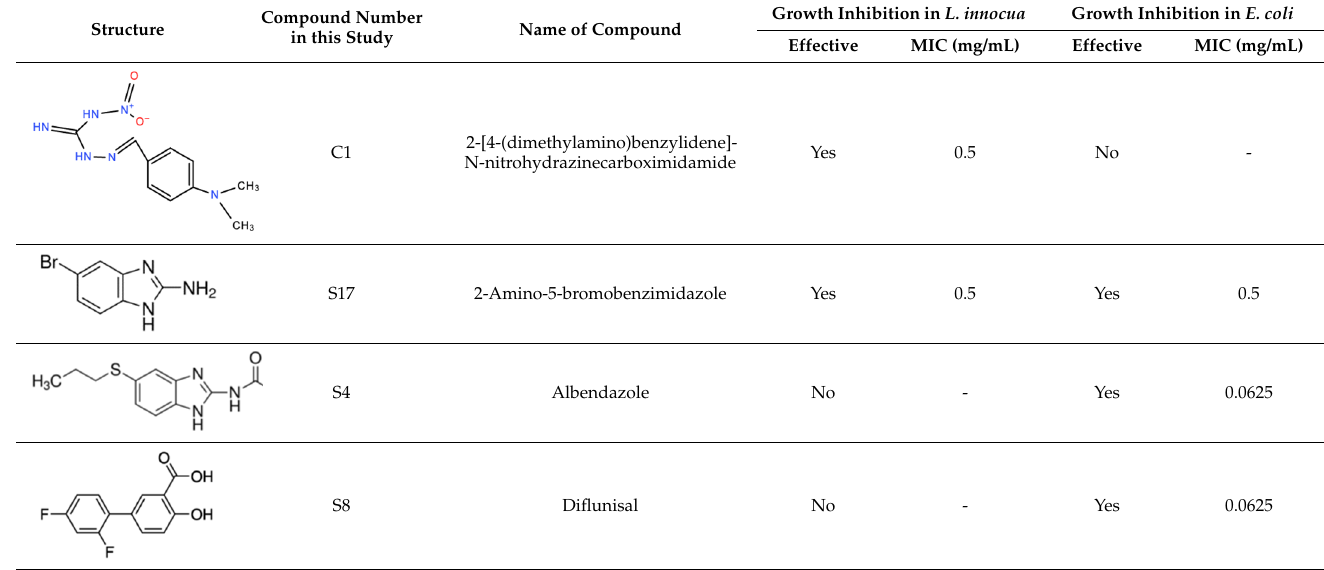
Table 1. Summary of the bacterial growth inhibition effects of identified MurA inhibitors. Structure Structure